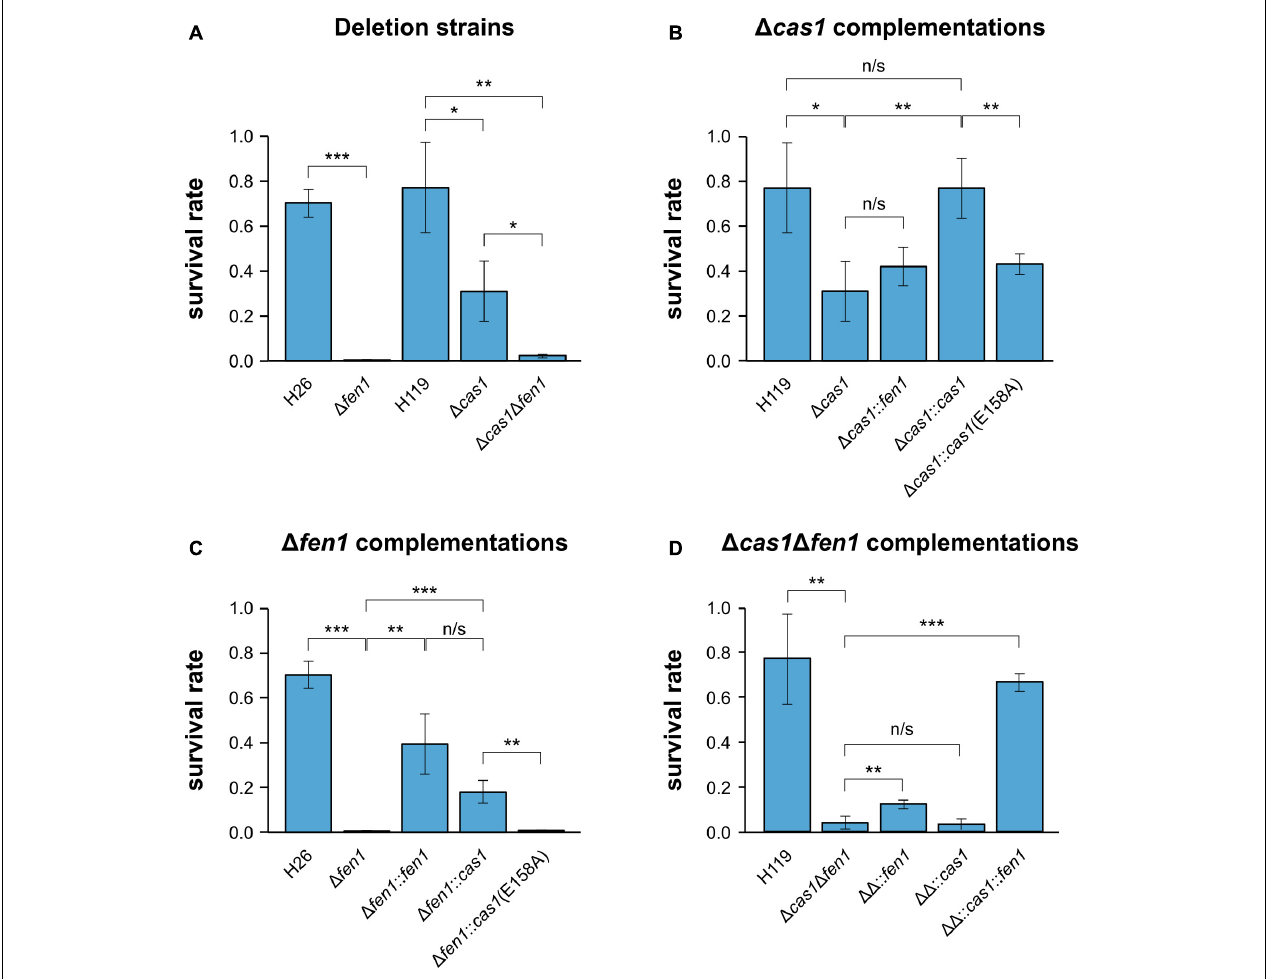
FIGURE 1 | Survival rates of Haloferax volcanii exposed to 4 mM H 2 O 2 . Haloferax volcanii strains were grown to the mid-log growth phase, exposed for 1 h to 4 mM H 2 O 2 and survival rates were calculated by dividing the number of colony forming units (CFUs) determined for the exposed strains by the number of CFUs of an unexposed control. (A) Wild-type and single deletion strains as well as the double deletion strain were analysed. H26 is the wild-type strain for (cid:49) fen1, H119 is the wild-type strain for (cid:49) cas1 and (cid:49) c as1 (cid:49) fen1 ( Supplementary Table 4 ). (B) (cid:49) cas1 was complemented with fen1 , cas1 or a catalytically dead cas1 mutant [ cas1(E158A)] . (C) (cid:49) fen1 was complemented with fen1 , cas1 or the cas1 mutant. (D) (cid:49) cas1 (cid:49) fen1 ( (cid:49)(cid:49) ) was complemented with fen1 , cas1 or the cas1 mutant. Asterisks indicate significant differences ( t -test) between the survival rates based on three independent experiments; ***: highly significant (p-value < 0.001), ** very significant (p-value < 0.01), * significant (p-value < 0.05), n/s = not